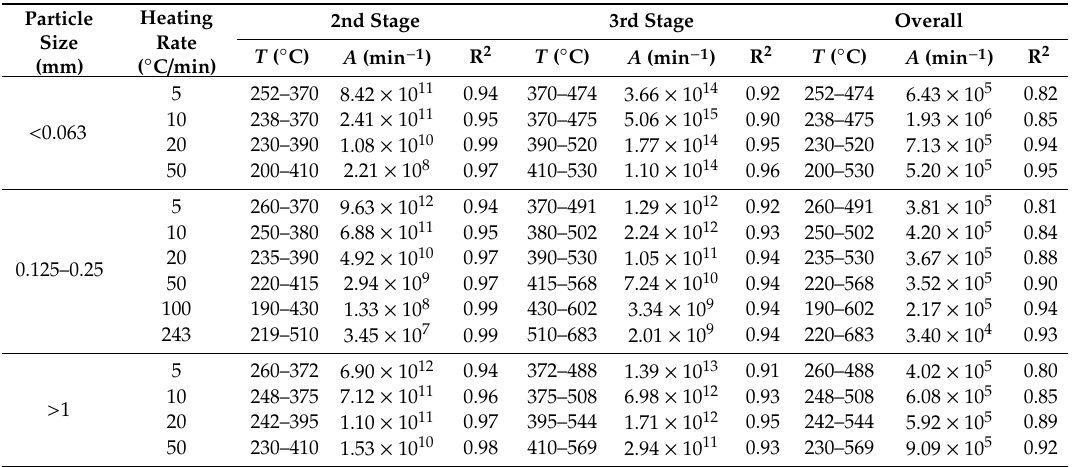
Table 6. Temperature intervals, correlation coe ffi cients, and pre-exponential factors for each stage of combustion for all particles studied under di ff erent heating rates.